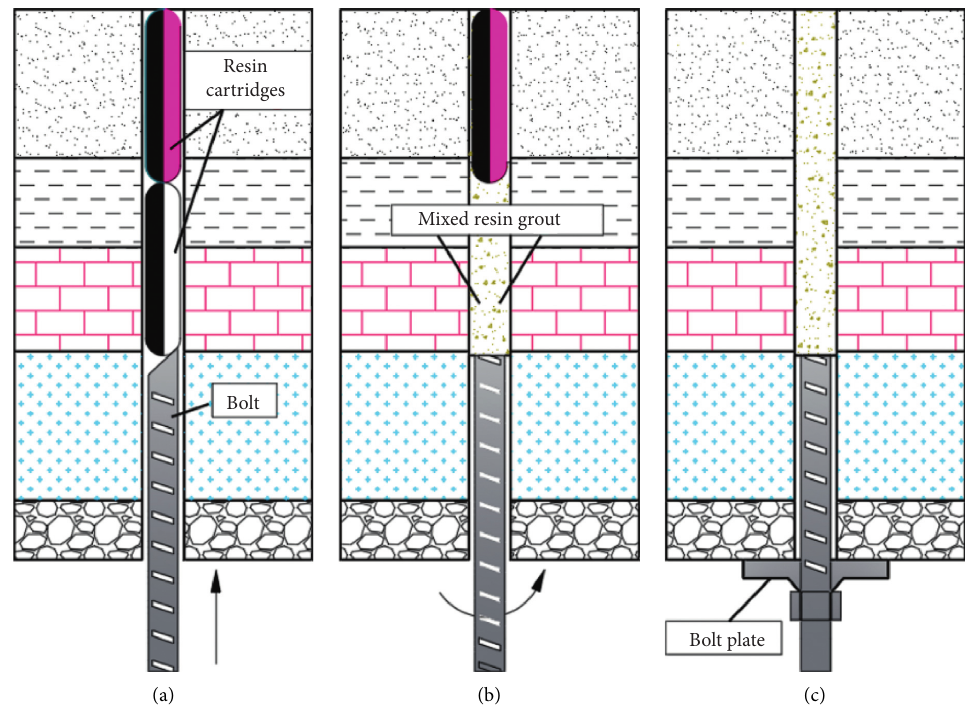
Figure 1: Bolt installation process. (a) Resin cartridges are inserted into the hole and pushed to the top of the bolt hole with the bolt. (b) Bolt is then rotated to mix the resin. (c) Rotation is stopped, followed by thrusting the bolt plate against the roof surface.